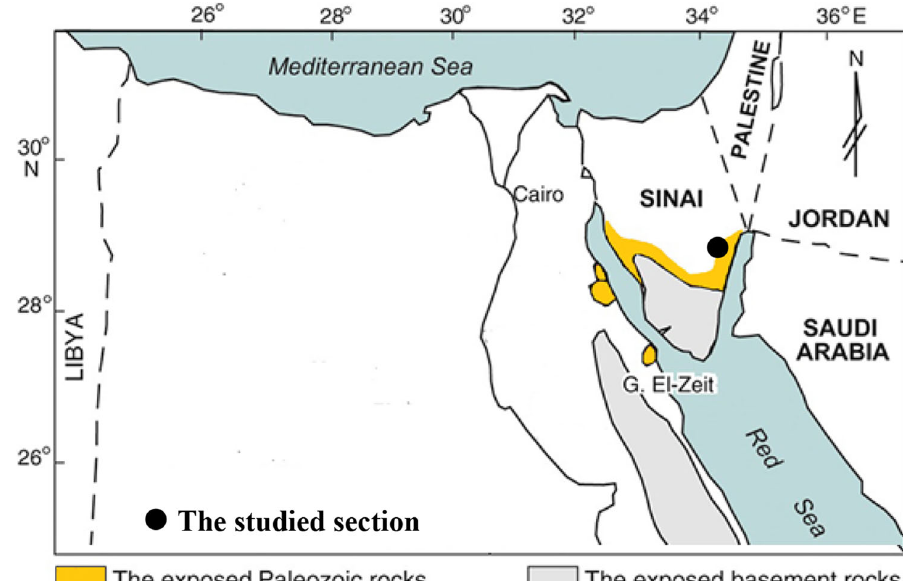
Fig. 1 Location map showing the areas of exposed Lower Paleozoic rocks in central Sinai (modified after Wanas